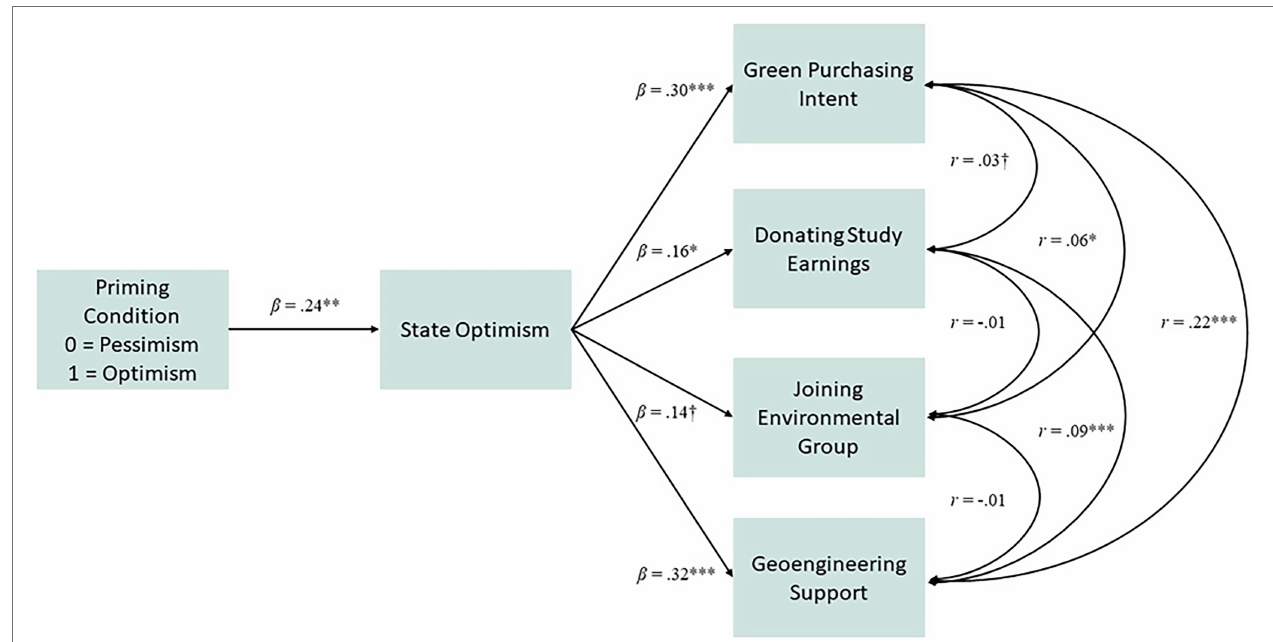
FIGURE 1 | Results of an observed variable path model analysis for examining the indirect effect of induced optimism on pro-environmental behavior, green purchasing intent, and support for geoengineering. Note that links between demographic control variables sex and age and the dependent variables are not depicted. † = p < 0.10, * = p < 0.05, ** = p < 0.01, and *** = p <